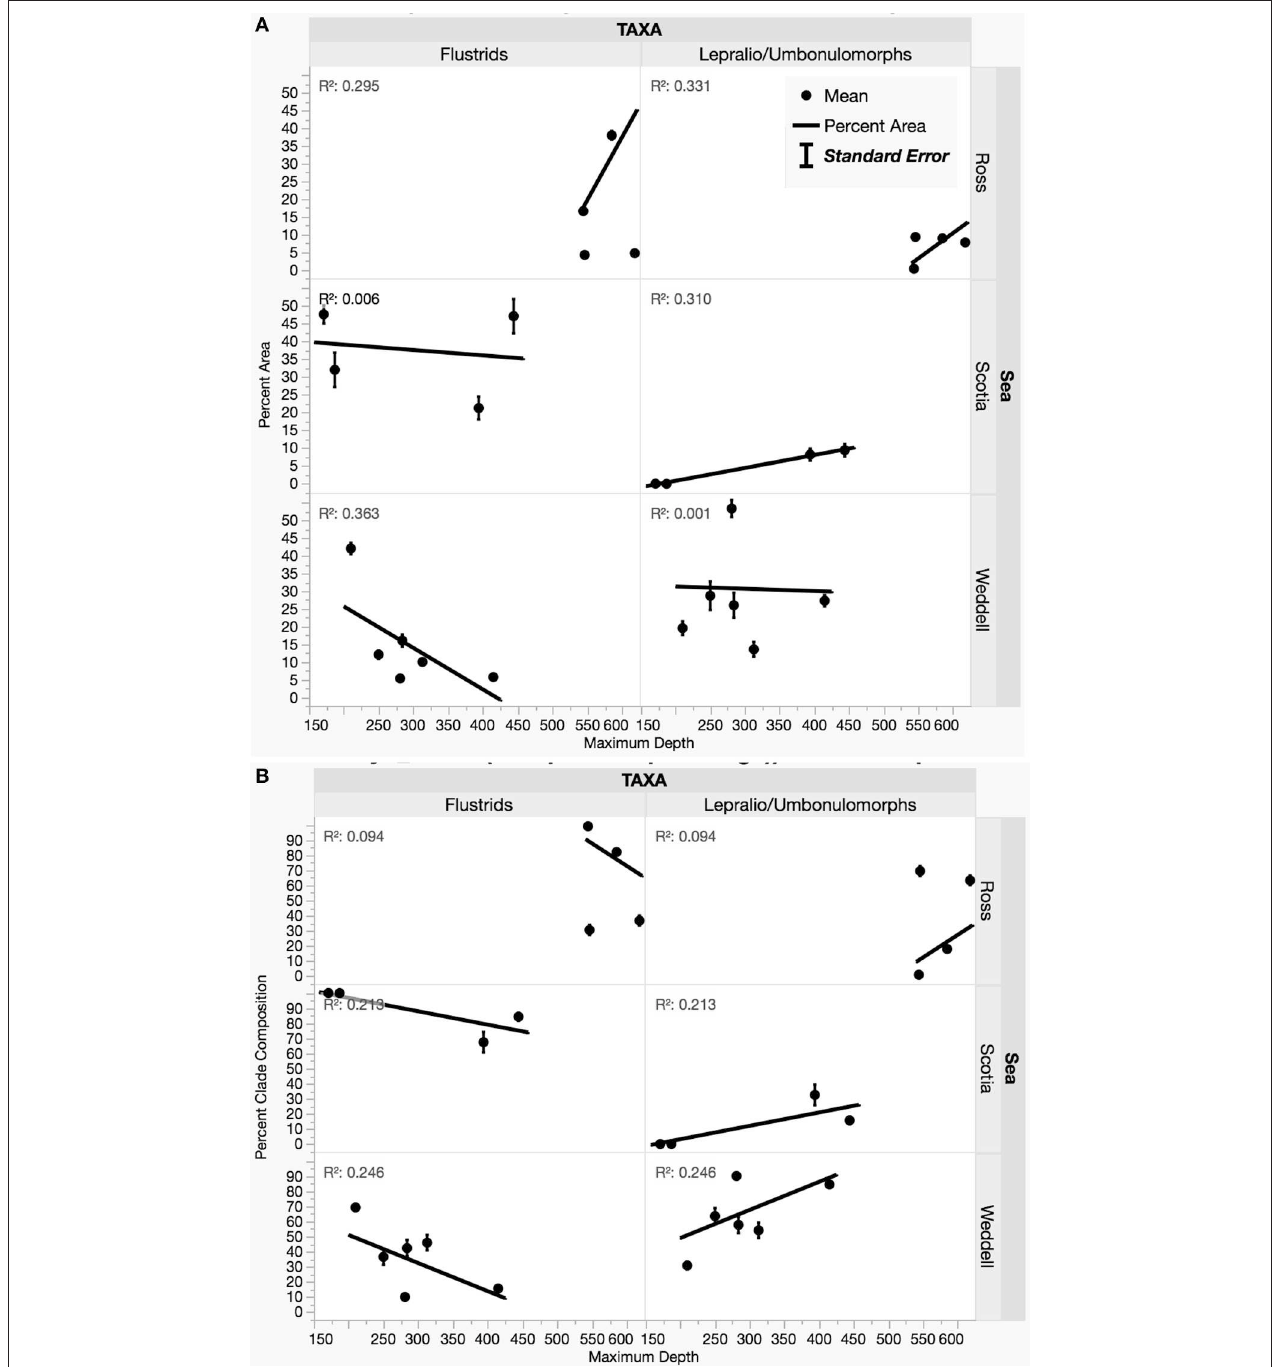
FIGURE 6 | Relationships among the percent area of flustrids and lepralio-umbonulomorph bryozoans by geographic region and depth. (A) Percent bryozoan area and depth. (B) Percent clade composition and depth.